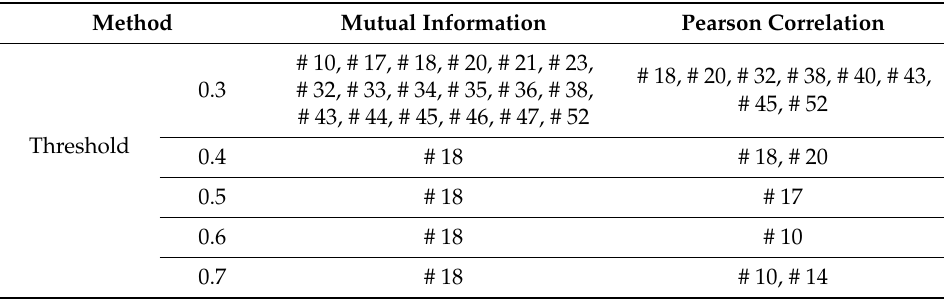
Table 5. The most important station according to threshold. The stations which have the highest value of centrality are chosen according to the threshold (0.3, 0.4, 0.5, 0.6, 0.7). The mutual information results have consistent results, but the Pearson correlation results have